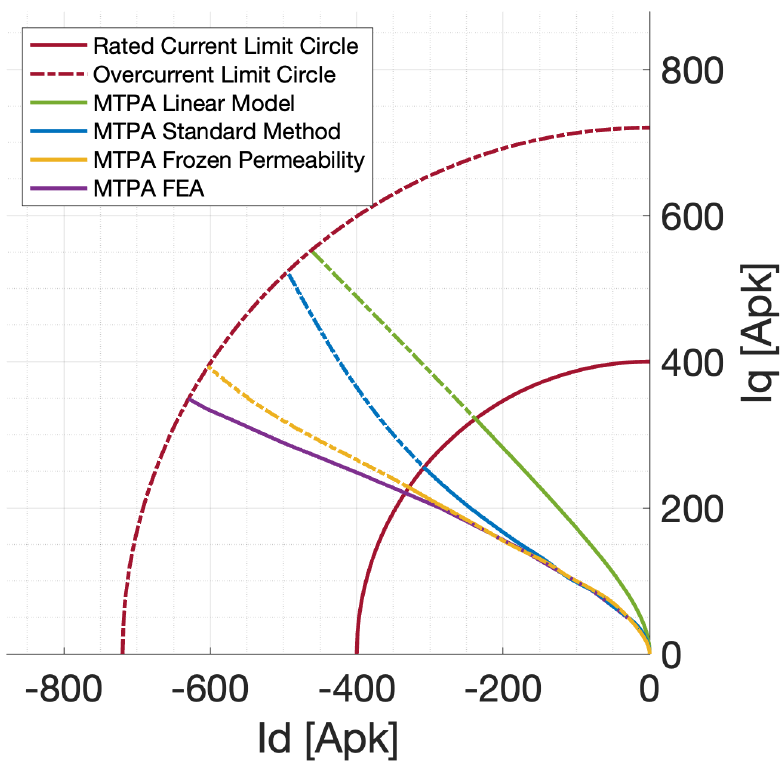
Figure 14. Comparison of MTPA curve obtained by the conventional linear model, nonlinear model based on Standard Method, nonlinear model based on FP and direct computation via 2D